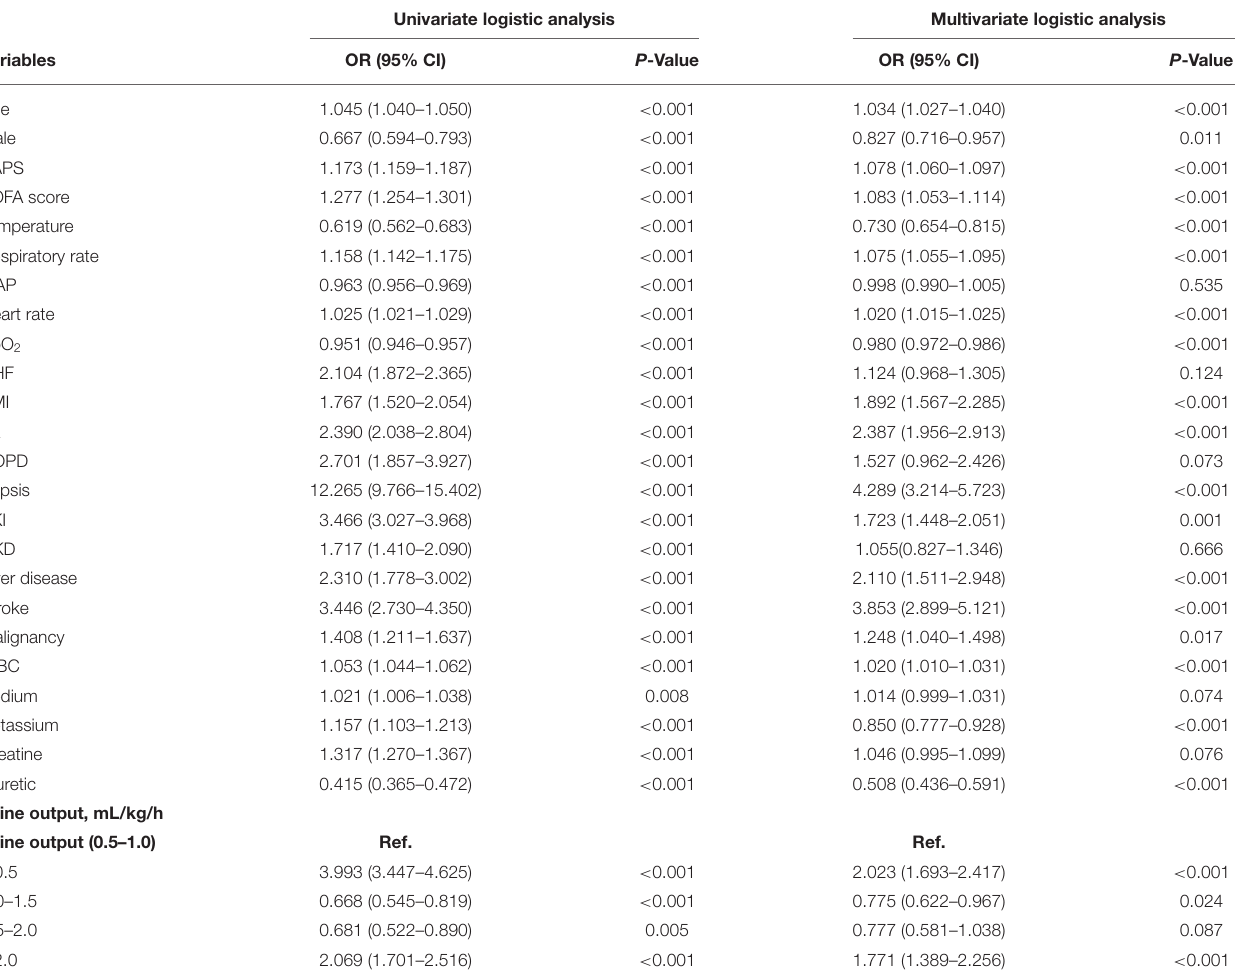
TABLE 2 | Univariate and multivariate logistic regression analyses for 30-day mortality. Univariate logistic analysis Multivariate logistic